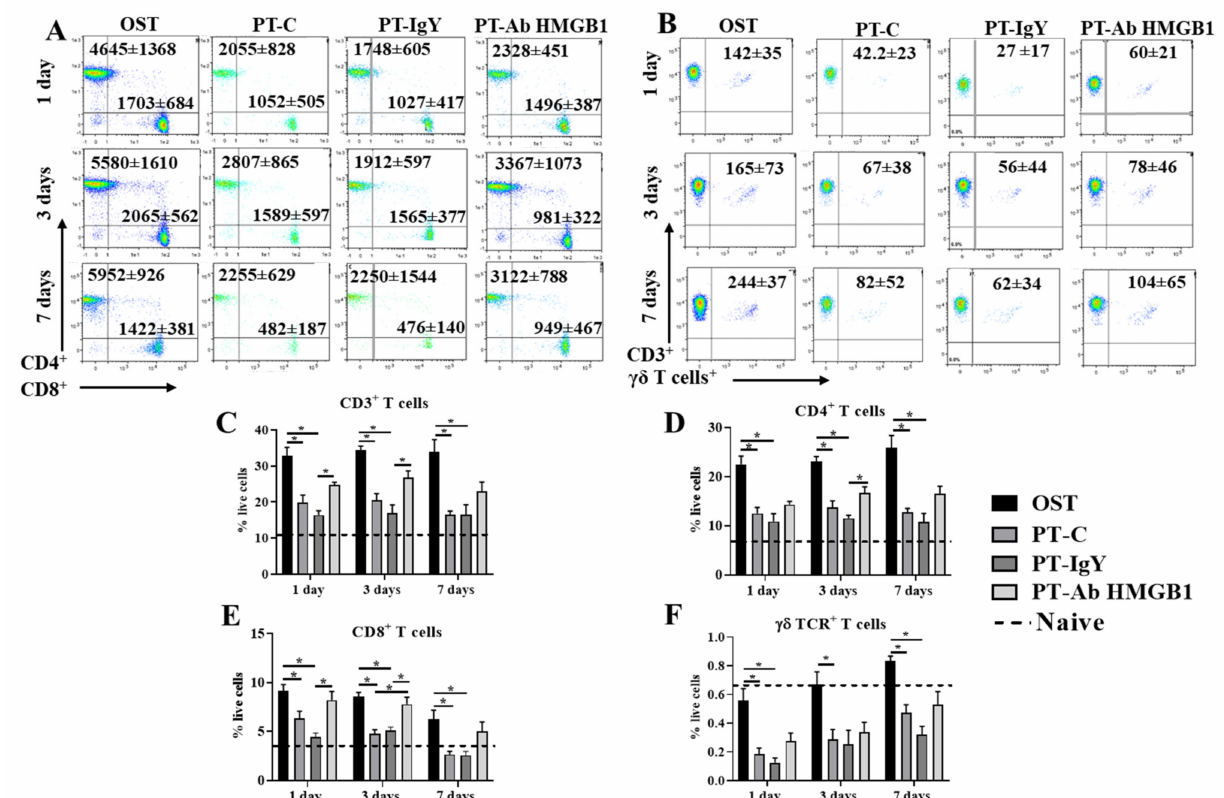
Figure 4. Flow cytometry representative dot plots with mean cell counts ± standard deviation for ( A ) CD3 + CD4 + and CD3 + CD8 + T cells and ( B ) CD3 + γδ TCR + T cell counts in blood at 1, 3 and 7 days post-trauma (dpt) in osteotomy (OST; n = 10), polytrauma (PT-C; n = 10), polytrauma + IgY (PT-IgY; n = 5 for 1 and 3 dpt; n = 4 for 7 dpt) and polytrauma + anti-HMGB1 antibody (PT-Ab HMGB1; n = 10) rats; ( C ) percent (%) CD3 + ; ( D ) % CD3 + CD4 + ; ( E ) % CD3 + CD8 + ; ( F ) % CD3 + γδ TCR T cells in blood from rats with OST, PT-C, PT-IgY and PT-Ab HMGB1 at 1, 3 and 7 dpt. Naïve uninjured rats were used as baseline controls ( n = 5). The dotted line is the mean of cell counts from naïve rats. * p < 0.05 comparing OST, PT-C, PT-IgY and PT-Ab HMGB1 cohorts. The bar graphs represent mean, whereas error bars represent